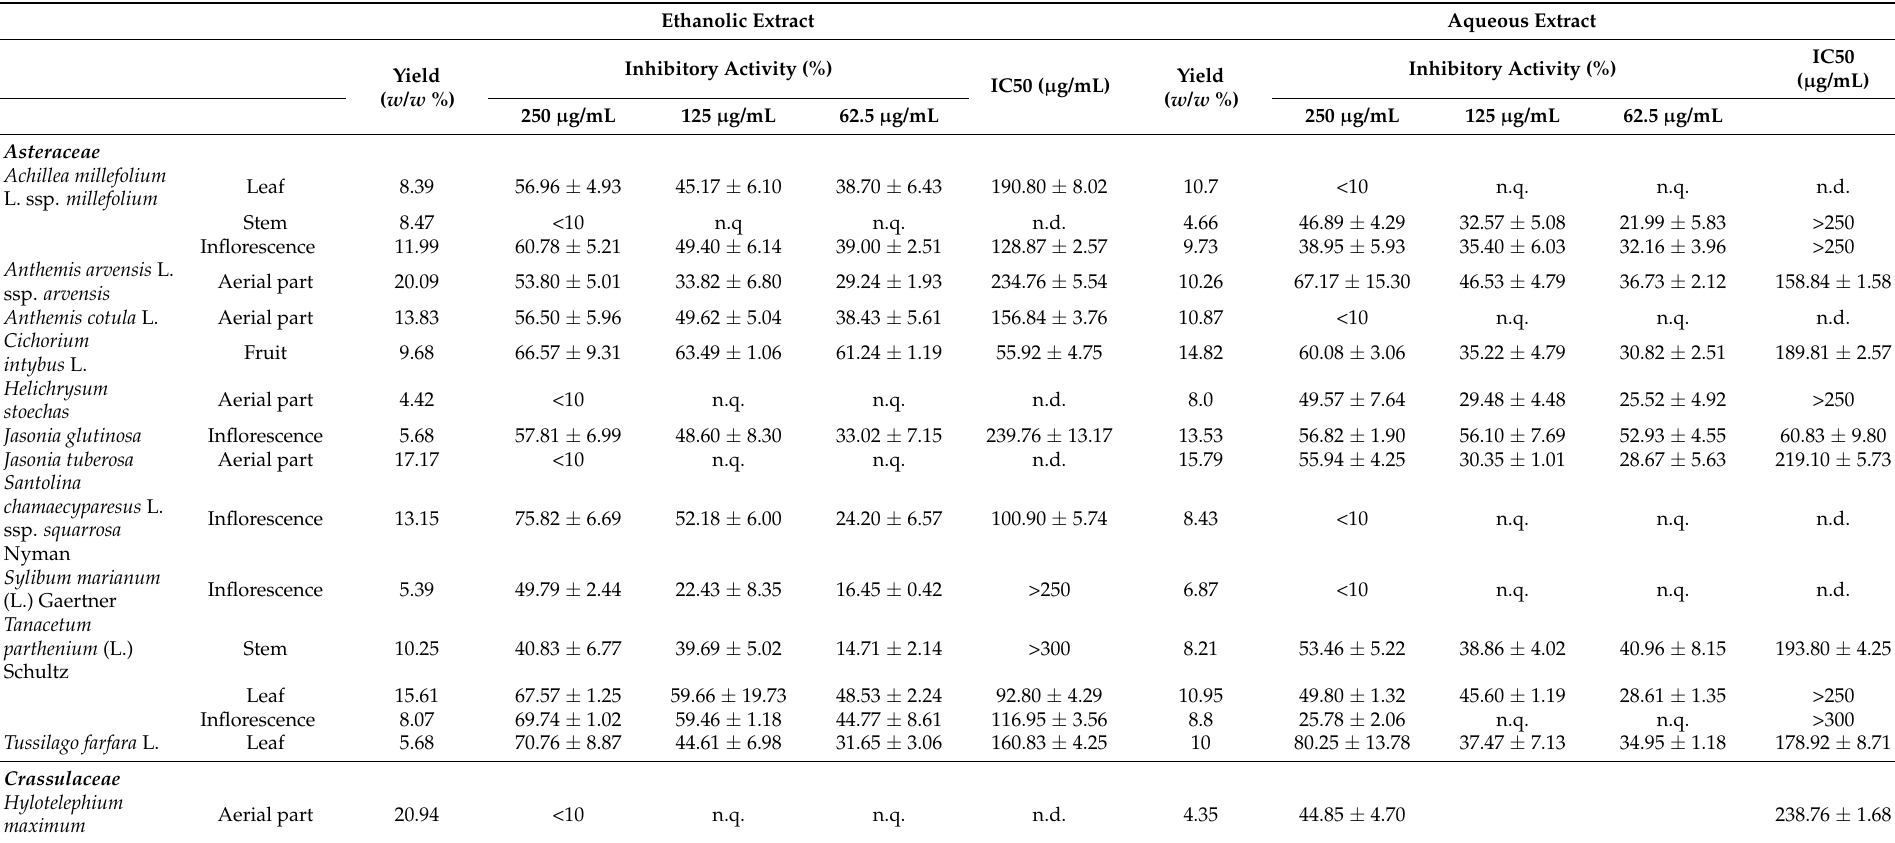
Table 1. Yields ( w/w %) and acetylcholinesterase inhibitory activity, expressed as percentage (%) and IC50 ( µ g/mL) of the ethanolic and aqueous